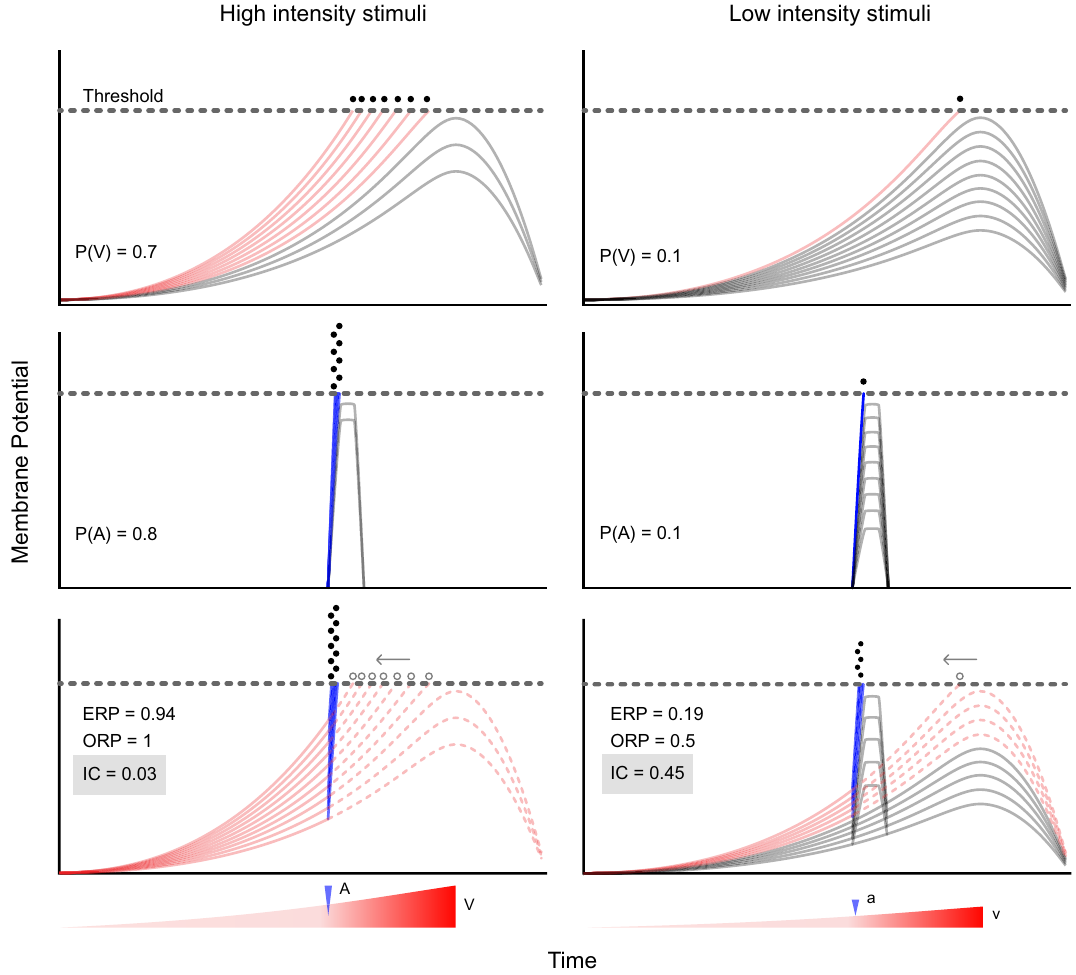
Figure 7. Conceptual model of multisensory integration in the Mauthner cell. Mauthner cells showed a ramped depolarization as a consequence of the increasing visual expansion (red triangles, bottom) or brief auditory pips (blue arrowhead, bottom). Differences in cell excitability or other factors will produce different rates of depolarization in different cells (different curves in the same panel). In the example, 7 out of 10 cells reached threshold with a strong loom (upper left) while only 1 out of 10 of those cells reached threshold with a low intensity loom (upper right). A similar scenario can be observed when comparing strong and weak auditory stimuli (left and right middle panels), yielding 0.8 and 0.1 response probability, respectively. The effect of combining two strong or two weak stimuli is exemplified in the bottom panels. A strong multisensory stimulus will depolarize all cells until threshold is reached (locked to the presentation of the auditory stimulus, black dots) but the relative enhancement of response probability (0.94–1) would be minimal (6%, IC = 0.03). In sharp contrast, two weak stimuli having a unisensory response probability of 0.1 might be combined to produce a summed depolarization that drives the Mauthner cell to threshold on 50% of the population (raising the IC = 0.45). The time point where each cell would have crossed threshold in the visual only condition (empty gray dots, lower panels) shifts to the moment when the auditory stimulus occurs (black dots, lower panels). Curves indicate Mauthner cell depolarization in response to a visual loom colored red if it reaches threshold or grey if it does not. Each plot indicates either the visual (P(V)) or auditory (P(A)) unimodal response probability or the Expected (ERP) and Observed (ORP) response probability and the resulting Integration Coefficient projection screen for the visual stimuli. The bottom of the tank was transparent, allowing for simultaneous video recording of fish behavior and stimulus presentation at 240 fps (432 × 320 pixels, Casio EX ZR100, Tokyo, Japan). A green LED located below the experimental tank (hidden from animal’s view) was used to allow the camera to record the time of auditory stimulus onset. Experiments were made in a silent room with ceiling lights off. Presentation of visual and auditory stimuli as well as camera acquisition and LED activation was controlled by MATLAB (R2016a, www. mathw orks. com). Triggering of video acquisition occurred simultaneously with visual stimulus onset and stopped 8.25 s after the end of visual stimulation.